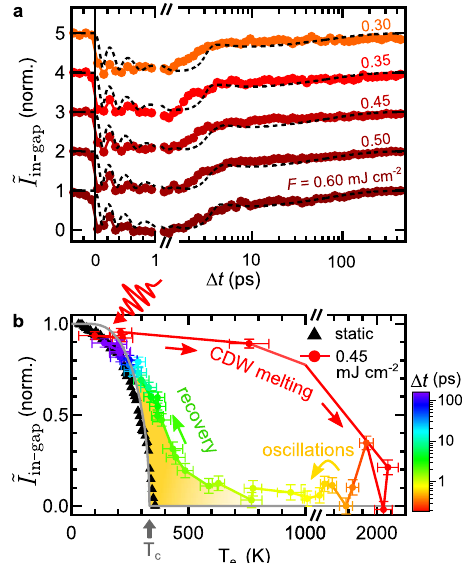
Fig. 3 CDW recovery dynamics. a Time evolution of the inverted in-gap intensity in the high- fl uence regime (displaced vertically). Normalized time- dependent Ginzburg – Landau simulations are shown in black. b Inverted in- gap intensity versus extracted electronic temperatures. One standard deviation of the T e fi t (horizontal error bars) and one standard deviation derived from electron counting statistics (vertical error bars) are given as uncertainty. ~ I in (cid:1) gap extracted from a static temperature series (black markers, T values from heater setpoints, curve normalized to the lowest accessible T value) is in general agreement with the BCS-type T - dependence of the order parameter (gray curve). The dynamic trace shows the full cycle of laser-heating and CDW melting, coherent oscillations and CDW recovery (delay encoded in the color code). The yellow shaded area marks the region of dynamical CDW formation at electronic temperatures above T c . The pre-excitation value of the dynamic trace ( T = 100 K) is normalized to the corresponding value of the static T